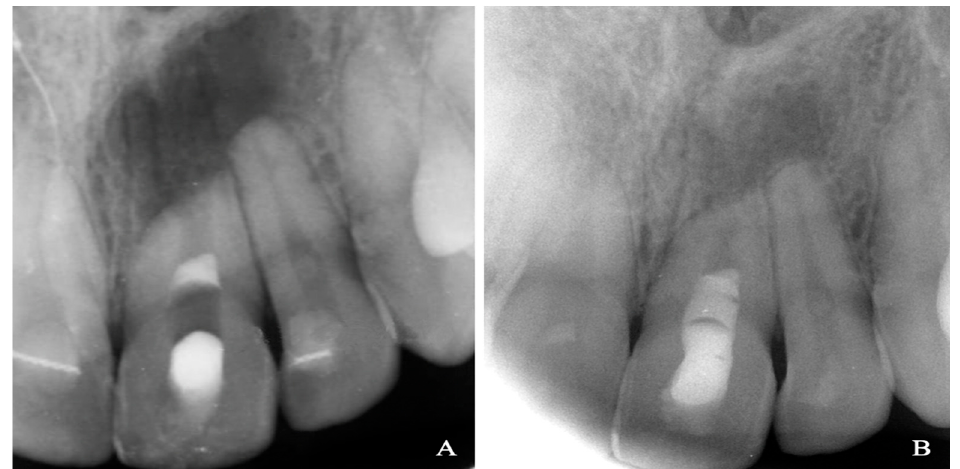
Figure 1. Maxillary right central incisor of a 23 year old female was diagnosed with pulp necrosis and chronic apical periodontitis. The patient reported a traumatic injury when she was 7 years old. Taking into account that the tooth exhibited an open apex, an REP with autologous PRP was performed. ( A ) Immediately periapical radiograph after REP. ( B ) Periapical radiograph after 1 year follow-up visit. The patient remained asymptomatic and periapical bone healing can be appreciated.